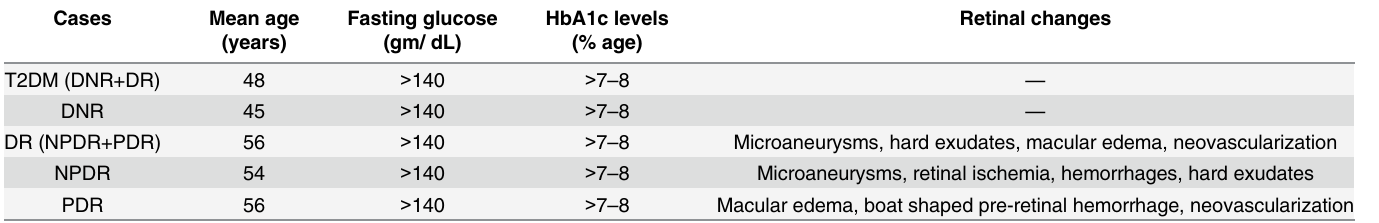
Table 1. Demographic data of the patients genotyped for ACE and PAI polymorphisms in the present study.